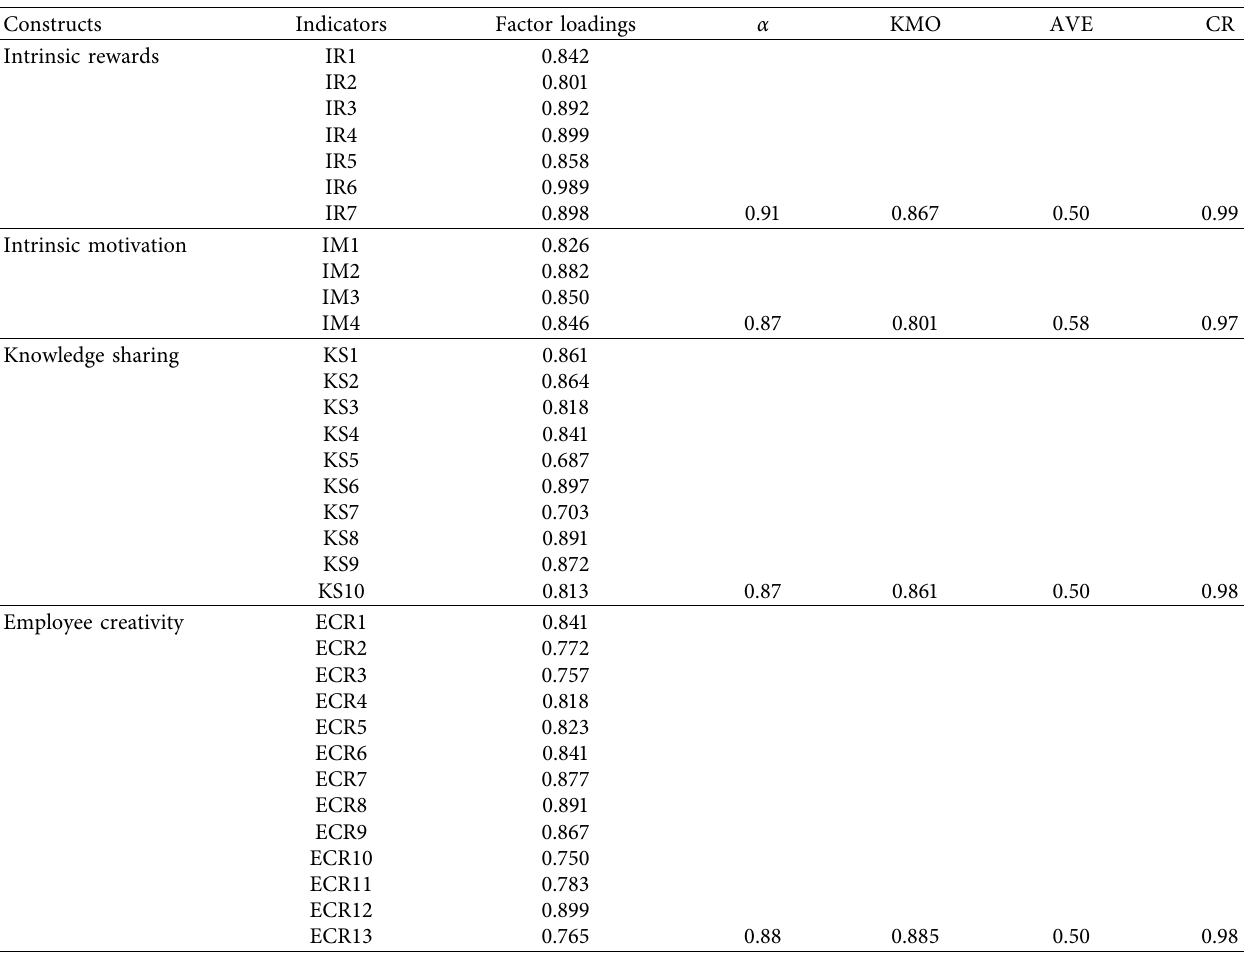
Table 1: The reliability of the constructs and factor loadings of